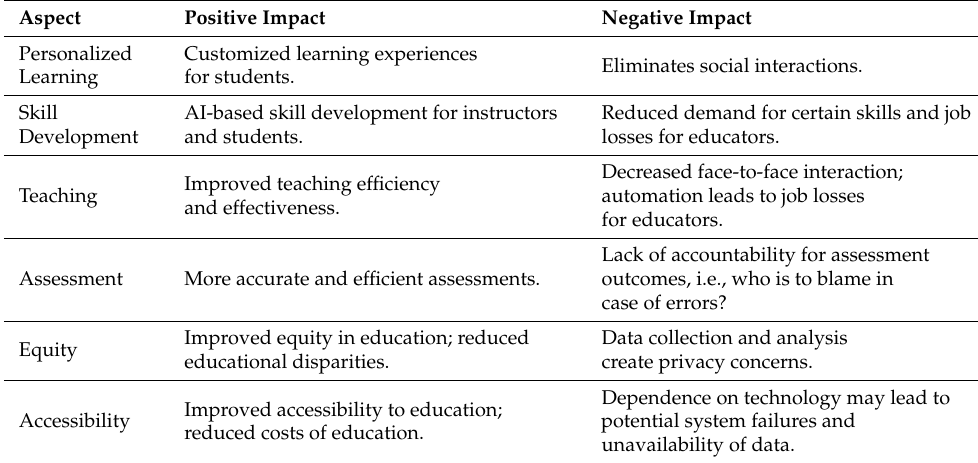
Table 12. AI as a disruptive tool and its positive and negative impacts on